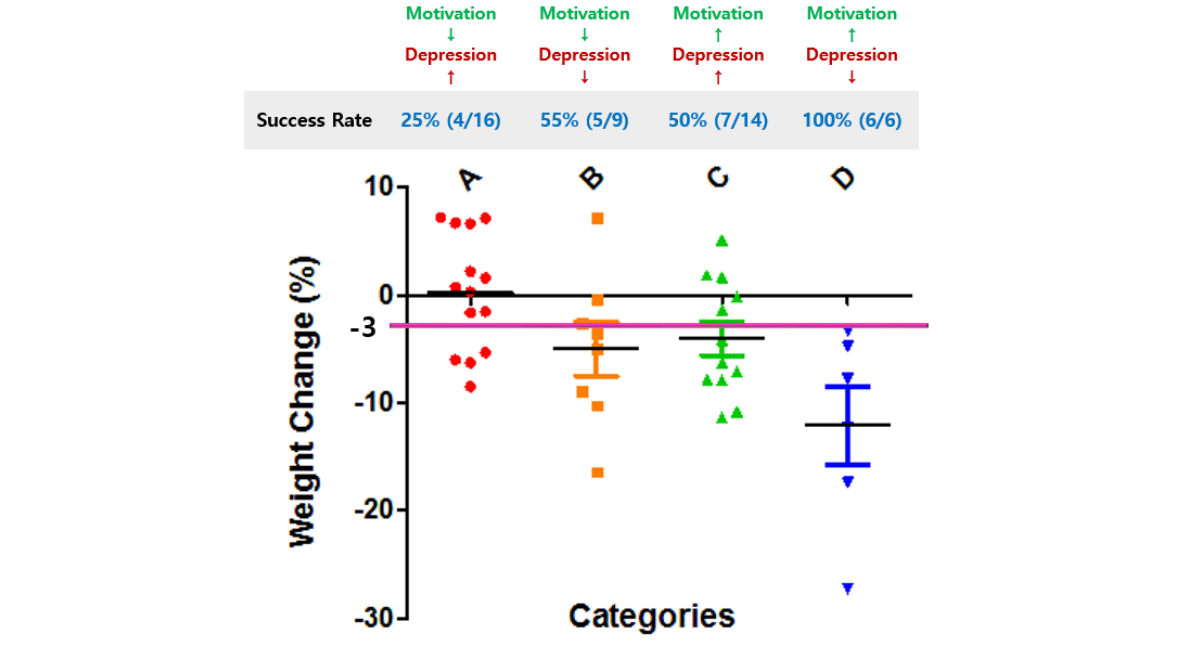
Figure 9. The clinical efficacy of digital cognitive behavioral therapy (CBT) by applying the optimal cutoff scores of the predictive markers in the clinical setting. The pink line represents the threshold for successful weight